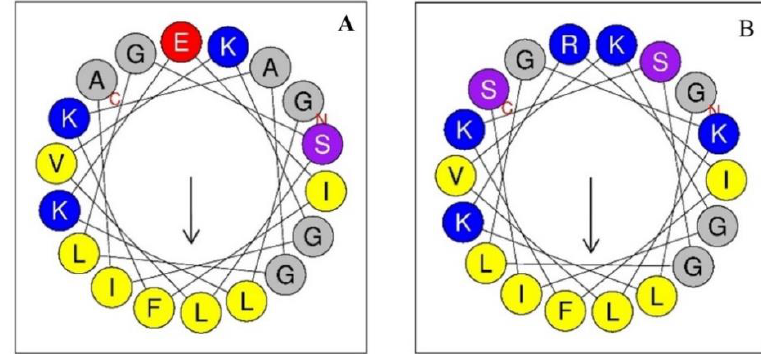
Figure 1. Wheel projections of the first 18 residues of the sequence of each peptide. ( A ) Alyteserin-1c peptide (+2); ( B ) peptide +5. The hydrophobic amino acids are yellow, and the charged amino acids are blue (net positive) or red (net negative). The polar amino acids are purple and those in-between are grey. 112